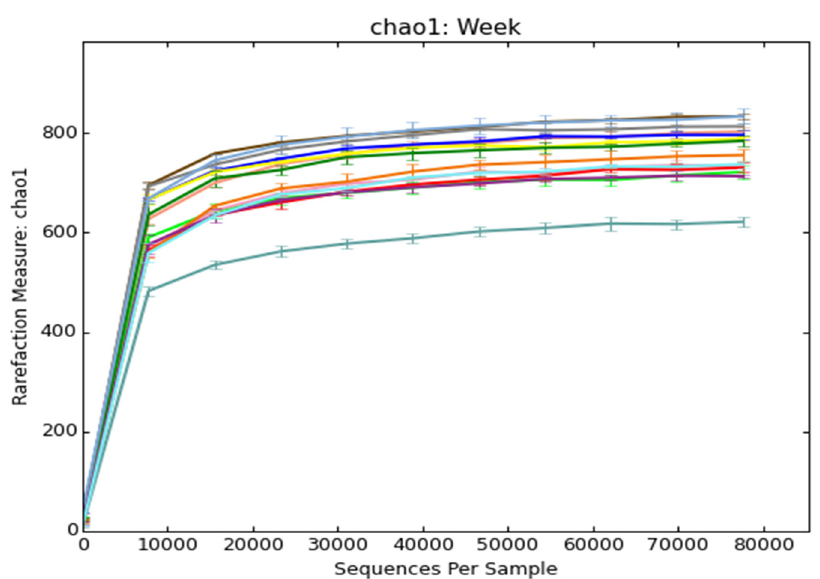
Figure 2. Rarefaction curve through chao1 for each week sample pooled from the three slurry pits; overall, the plot of all weeks shows a trend of consistent richness. The ending of the curves indicates the number of sequences obtained, as shown on the X axis. Rarefaction curve through the Observed_species, Shannon, and Simpson indexes are shown in the Supplementary Figures.